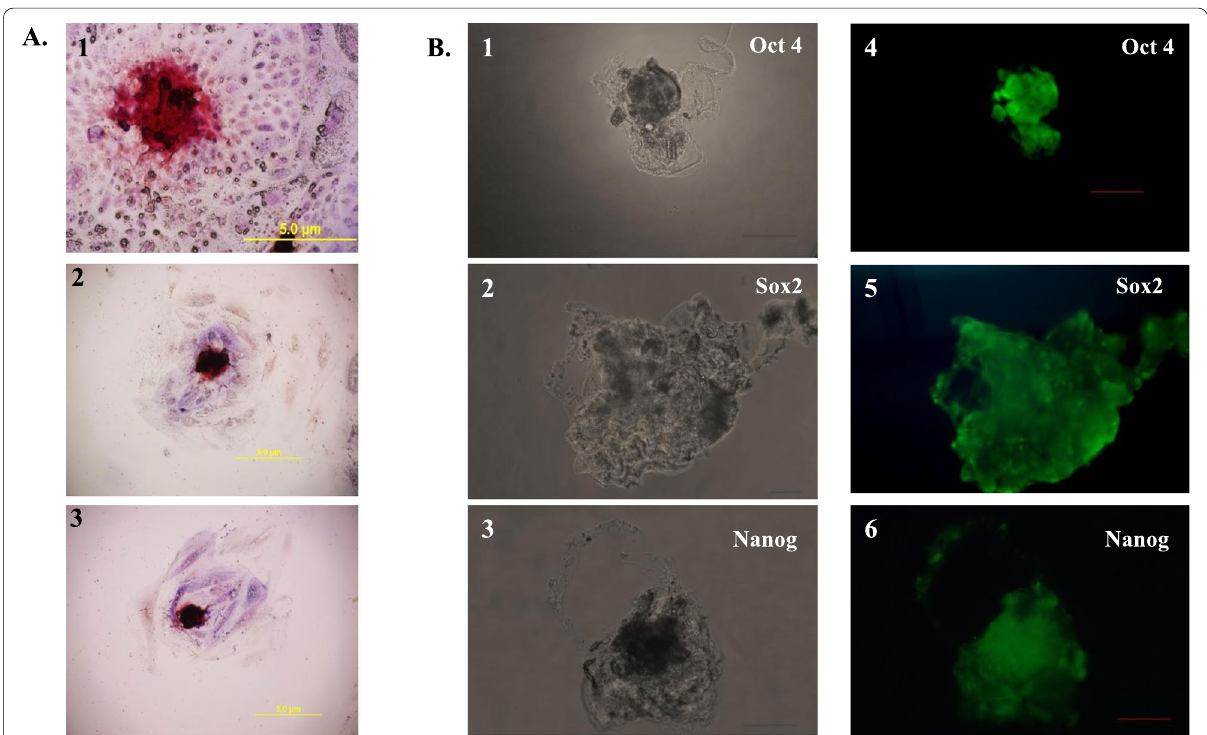
Fig. 6 Expression of stem cell markers associated with buffalo embryonic stem cells. A The putative buffalo embryonic stem cell colonies were analysed for alkaline phosphatase activity. The undifferentiated stem cells exhibited alkaline phosphatase activity, images (1–3, and); 50 μm. B Morphology of buESCs colonies (1–3) after 5 passages in medium containing 40 ng/ml BuLIF (bright field; scale bar 50 μm) and immunocytochemistry with anti-Oct-4 (4), anti-Sox-2 (5), and anti-Nanog (6), antisera, respectively, showed presence of stem cell markers in the stem cells. Scale bar: 100